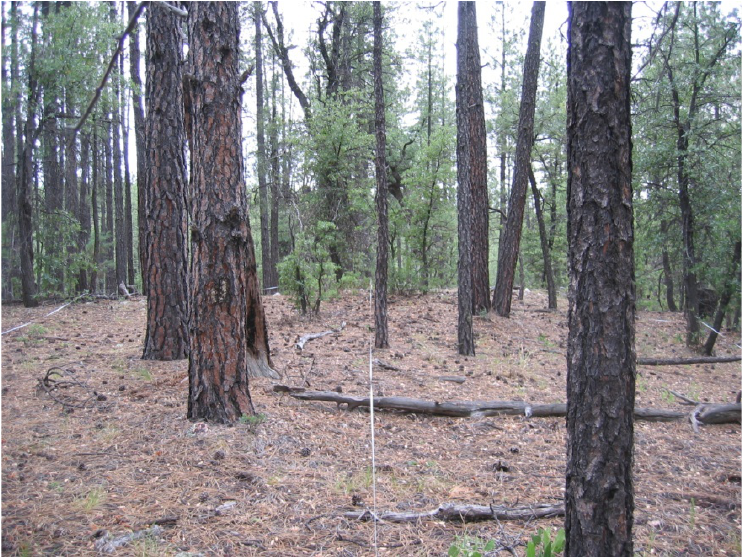
Figure 2. Unburned transect adjacent to the Dude Fire, Tonto National Forest,